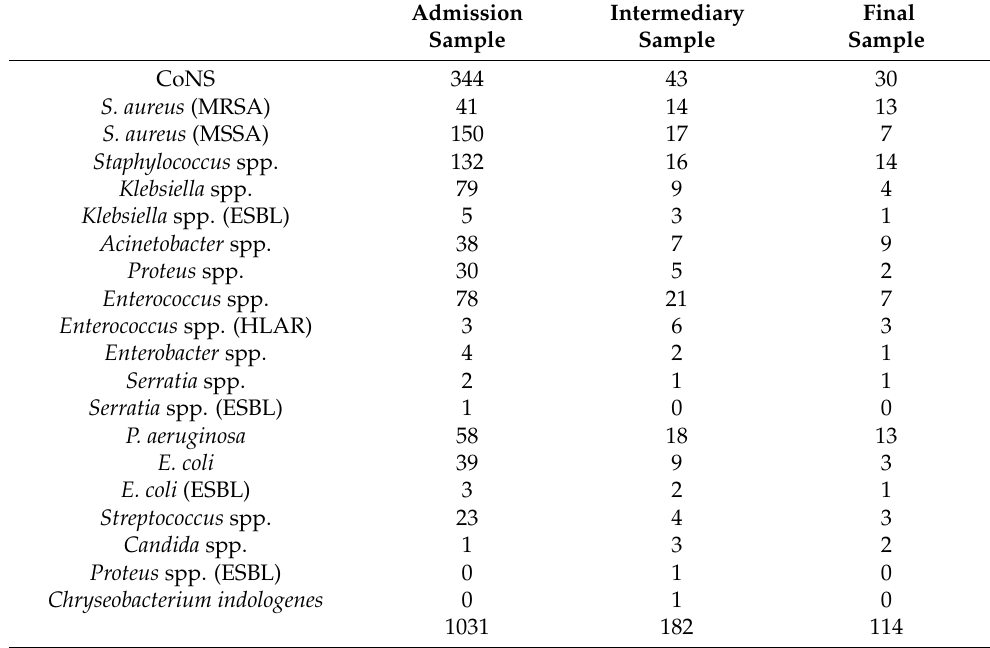
Table 11. Dynamic distribution of isolated